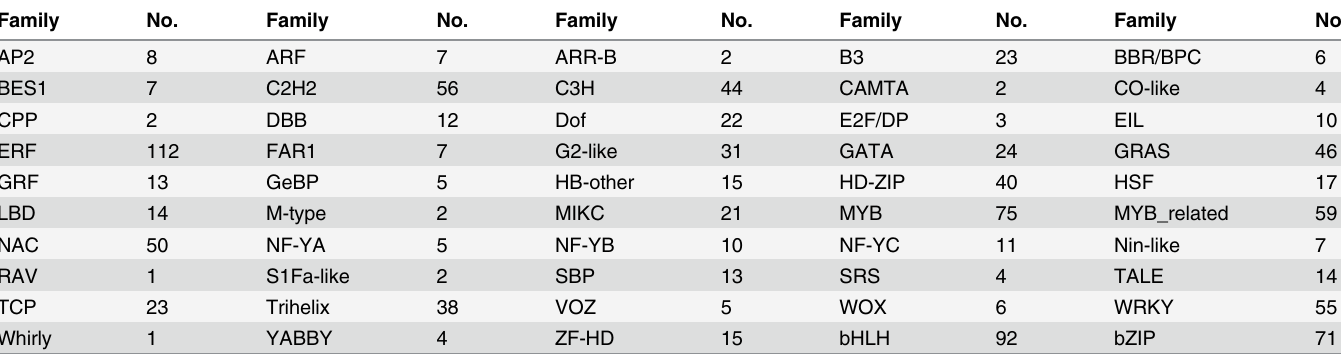
Table 1. Distribution of TFs in various families.